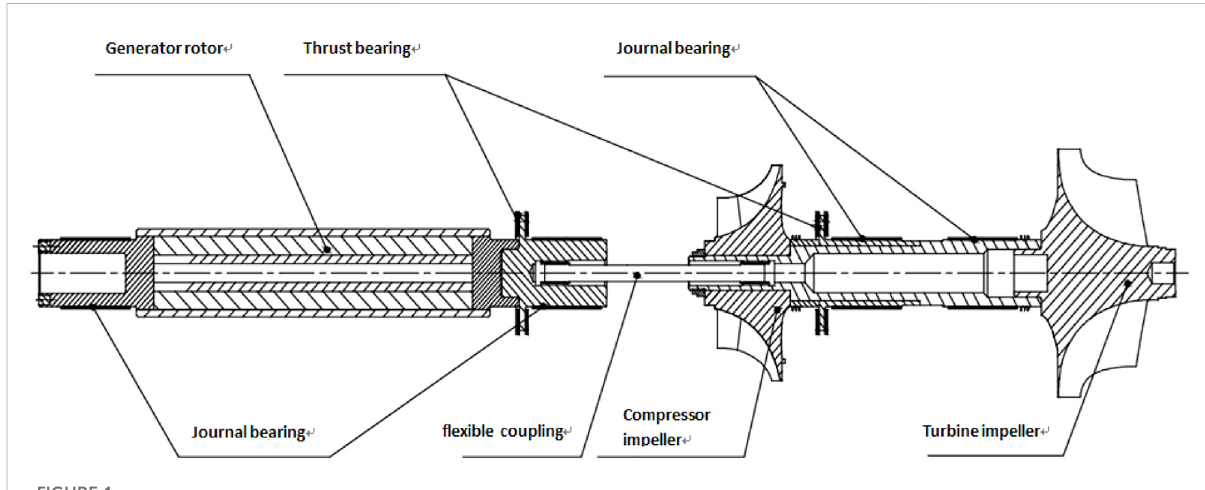
FIGURE 1 Micro gas turbine bearing-coupling-shaft system structure.